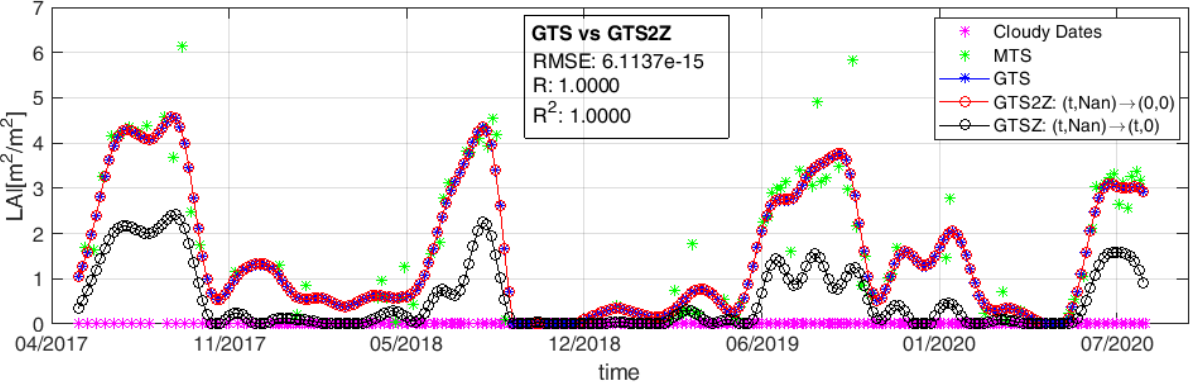
Figure 5. Result of GPR gapfilling of input LAI G time series—meaning values (MTS) plus cloudy acquisitions (CD)— using different approaches: standard GPR prediction (GTS), CD substitutions with 0 (GTSZ) and the proposed parallel implementation